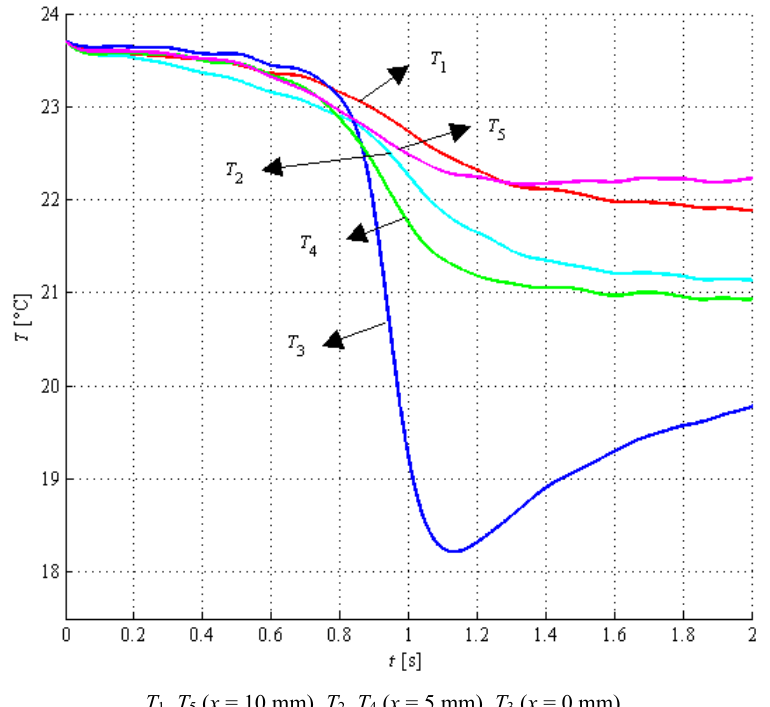
Figure 3. The example of temperature–time distribution curve T exp (t) for Inconel 718 and time of the nozzle moving across the plate ( v = 5 m/min and d = 0.5 mm) [10].